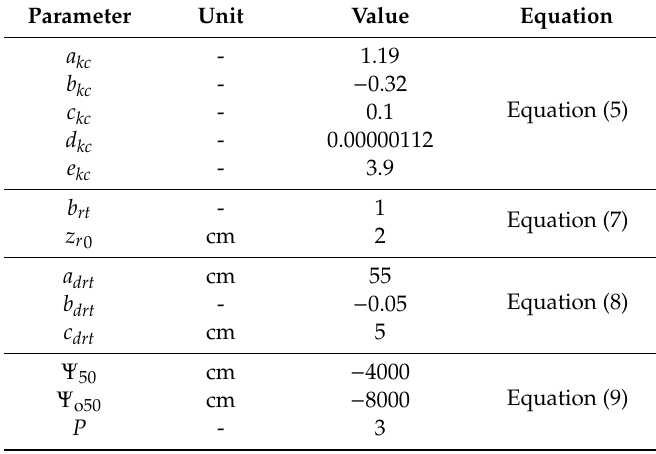
Table 2. Parameter values of plant growth and stress response function used for the numerical